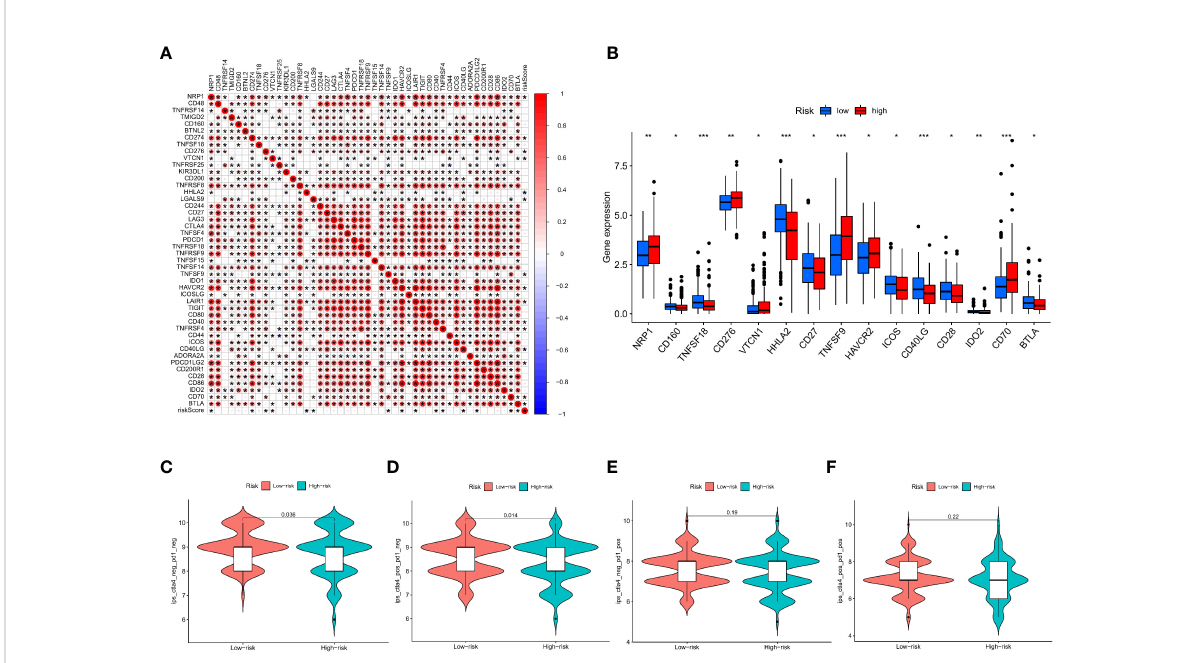
FIGURE 9 Based on the correlation between risk characteristics and immune checkpoint genes. (A) Correlation between the IMRG risk score and the 47 immune checkpoint genes; (B) Differential expression levels of immune checkpoint genes in the high- and low-risk groups; (C – F) The IPS evaluates the response to immunotherapy in the high- and low-risk groups; ***p < 0.001; **p < 0.01; *p <